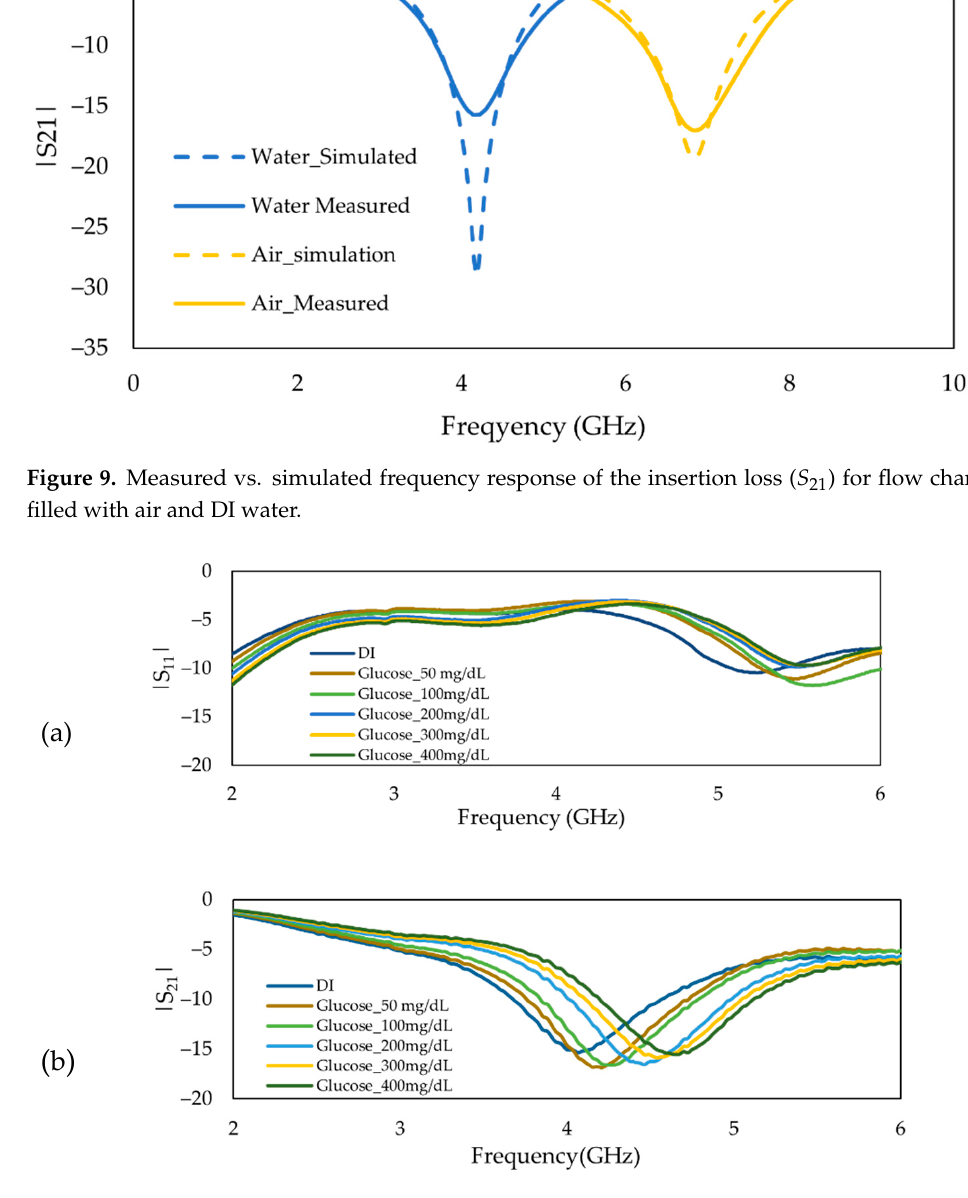
Figure 10. Frequency response of MIP-coated microwave-based stub biosensor ( a ) Reflection coefficient, S 11, and ( b ) Transmission coefficient, S 21 .